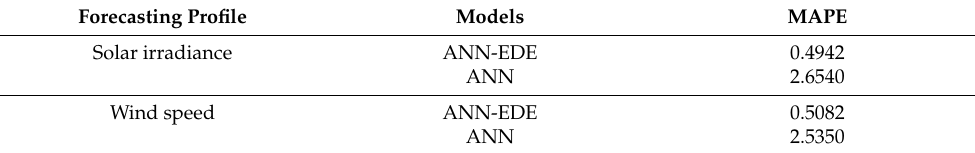
Table 4. Evaluation results of ANN-EDE and ANN prediction models in aspects of MAPE.